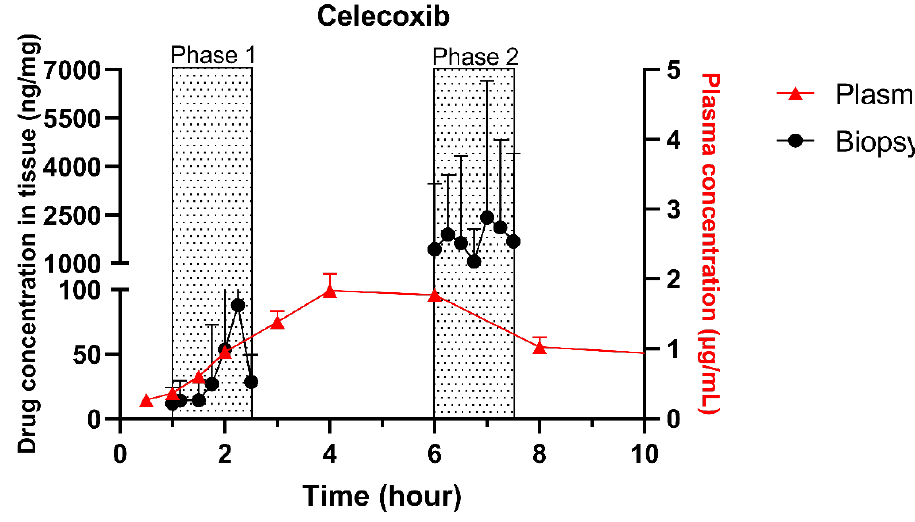
Figure 1. Concentration–time profile of celecoxib in plasma samples ( ▲ ) and cecal biopsies (●), col- lected from healthy volunteers after oral intake of one tablet of Celebrex (200 mg celecoxib) with 240 mL of water under fasted conditions. Adopted with permission from [43], Elsevier, 2020.